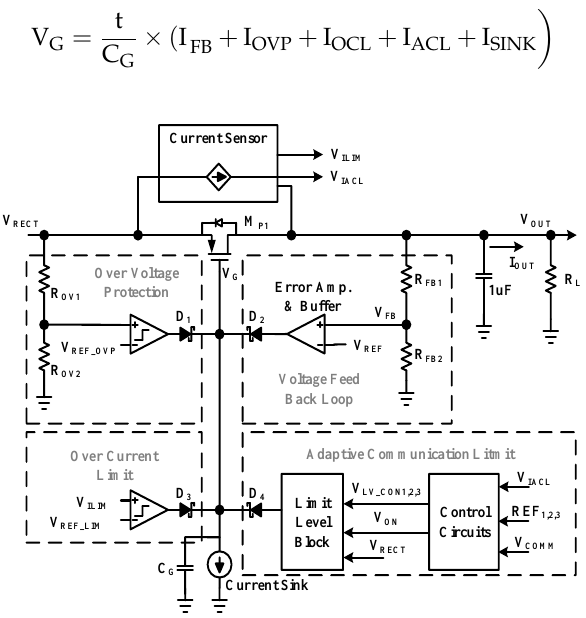
Figure 5. Multi-feedback LDO (MF-LDO)